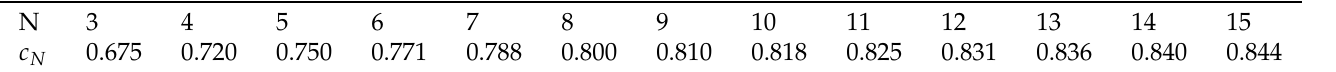
Table A1. Numerical values of of the ratios for